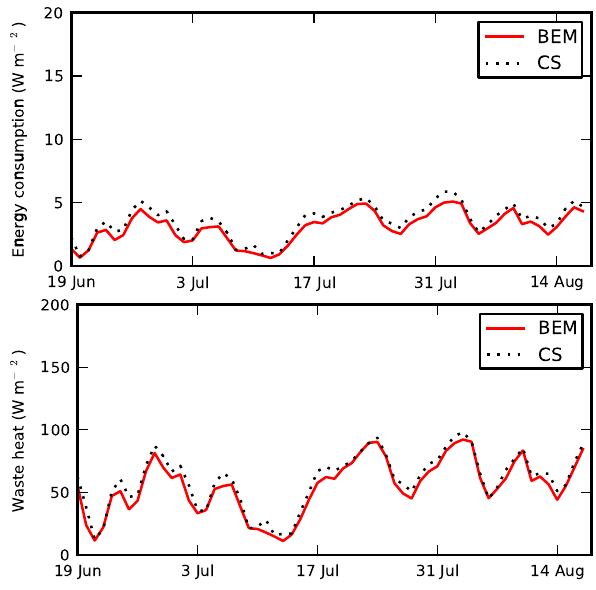
Fig. 8. Daily-average cooling energy consumption per unit of floor area (top) and waste heat emissions per unit of urban area (bottom) calculated by the coupled scheme and by BEM-TEB for the dense urban centre of Toulouse.